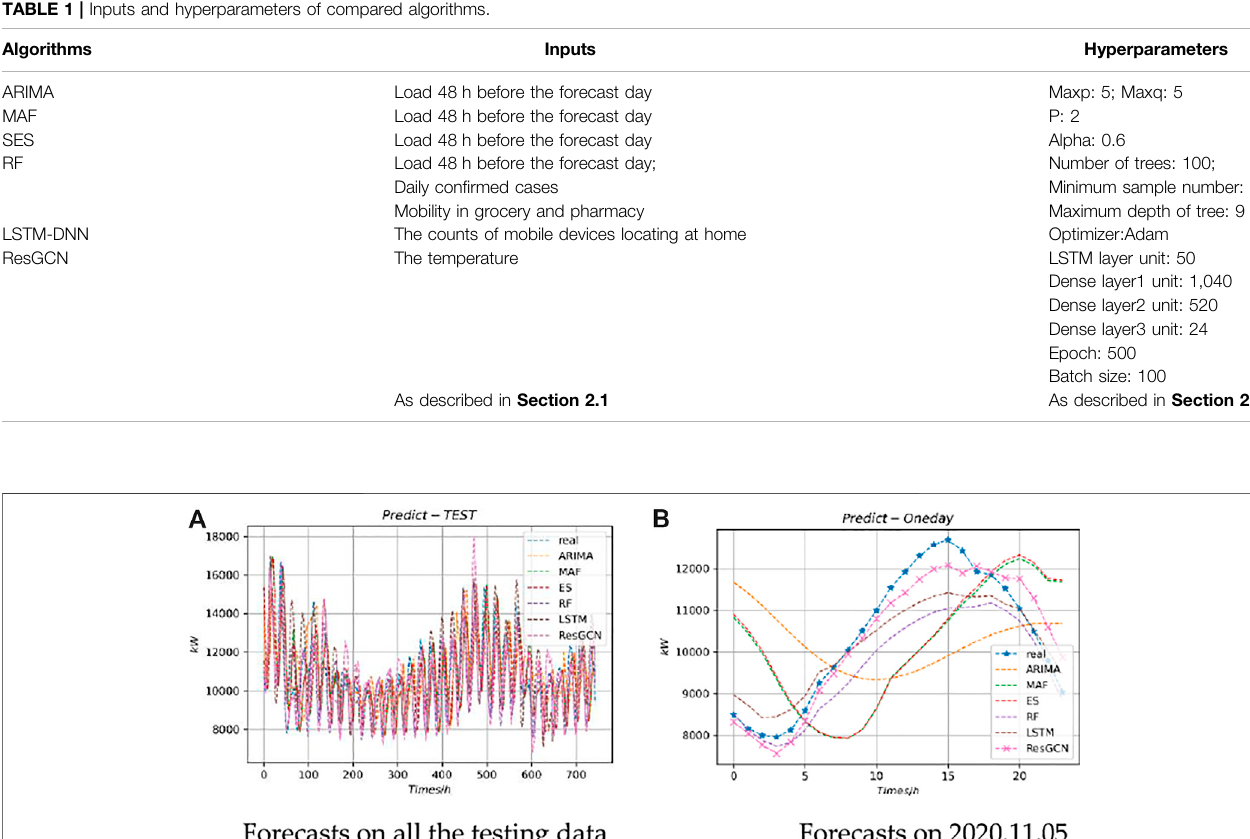
Frontiers in Energy Research |